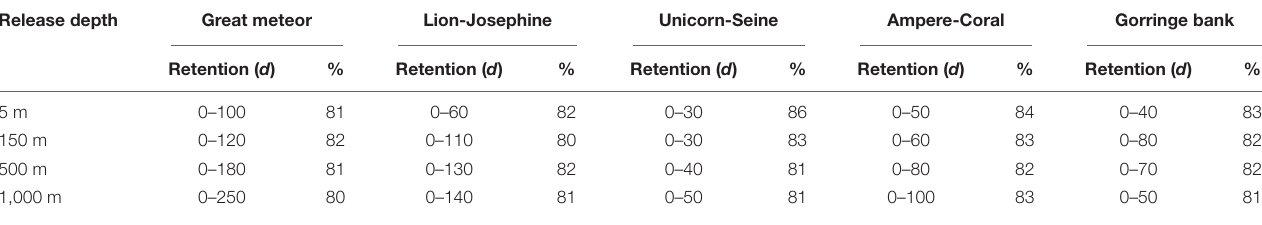
TABLE 3 | Retention time interval ( d ) that at least 80% of the captured particles spent inside each sink box, at each release depth, during the particle retention study. Release